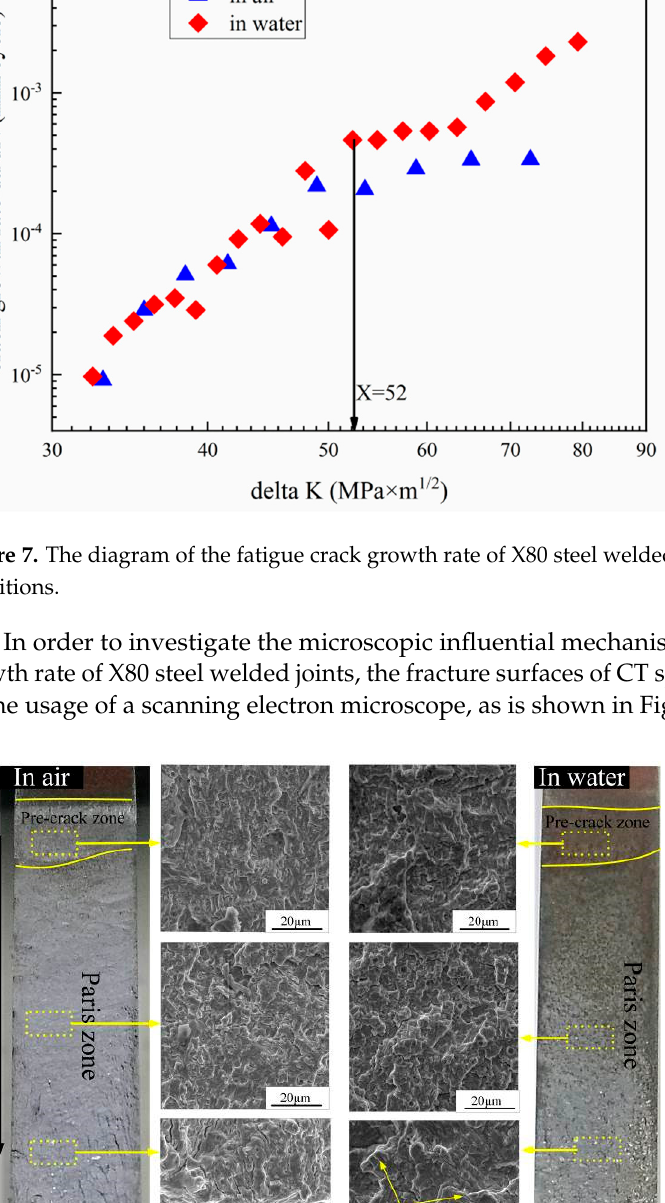
Figure 7. The diagram of the fatigue crack growth rate of X80 steel welded joints in the air and water conditions.